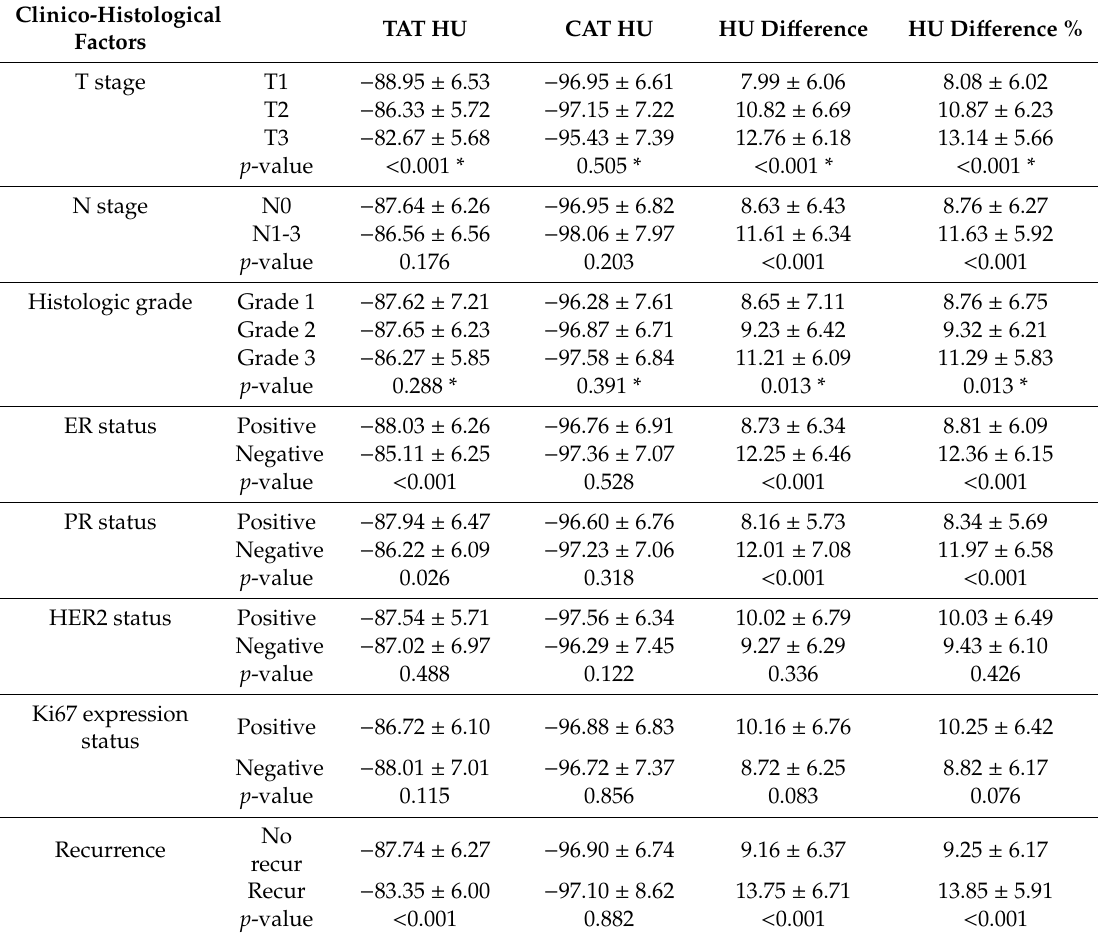
Table 2. Relationship between breast cancer adipose tissue parameters and clinico-histological factors.